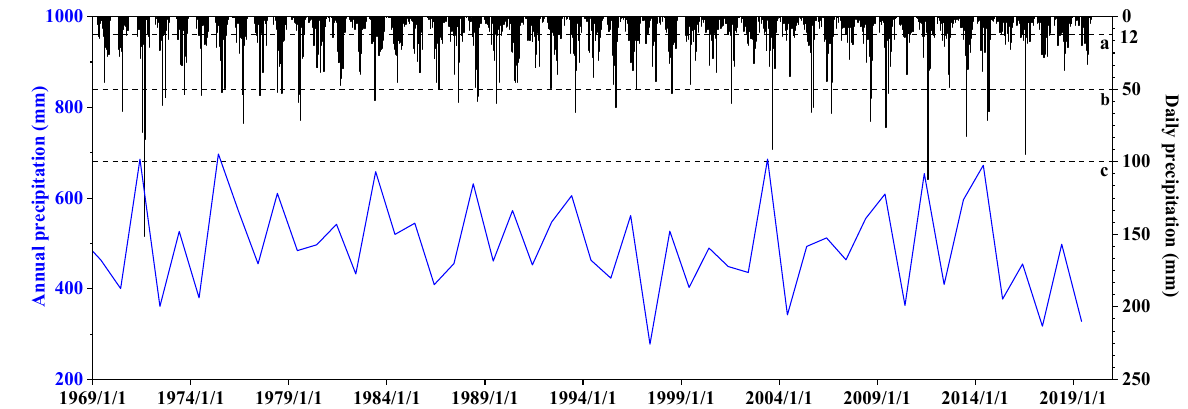
Figure 2. Daily precipitation record and annual precipitation from 1969 to 2019. The annual precipitation ranged from 277.6 to 697.4 mm, with an average of 496.62 mm. Annual erosive precipitation ranged from 130.4 to 588.0 mm, with an average of 302.81 mm. The thresholds of erosive precipitation (>12 mm · d − 1 ), rainstorms (>50 mm · d − 1 ), and heavy rainstorms (>100 mm · d − 1 ) are marked as dashed lines a, b, and c, respectively. From 1969 to 2019, there were 39 rainstorm events and 2 heavy rainstorm events (20–21 August 1971 and 29 July 2011, respectively).